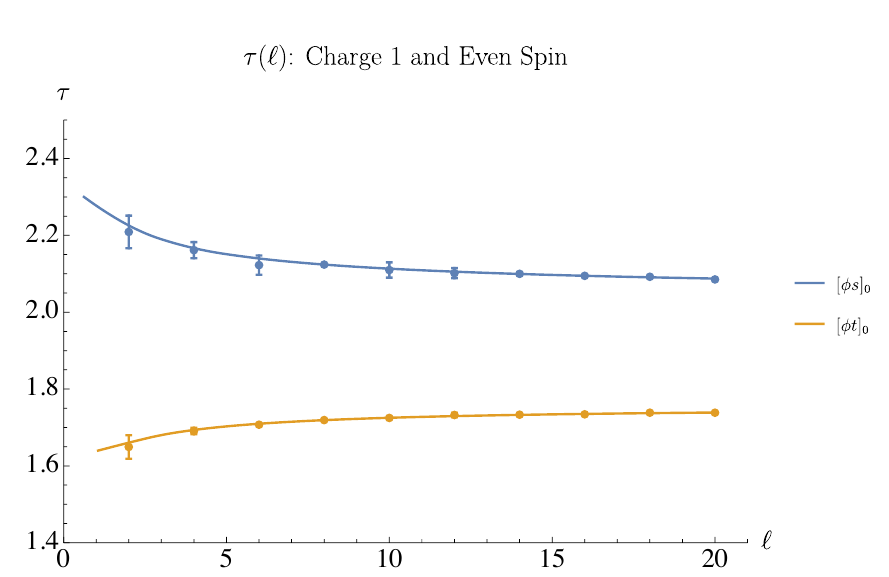
Figure 7 . Analytic and numerical predictions for twists of the double-twist trajectories [ (cid:30)s ] 1 with charge 1 and even spin. The blue curve represents the [ (cid:30)s ] 1 represents the [ (cid:30)t ] 1 trajectory. 0